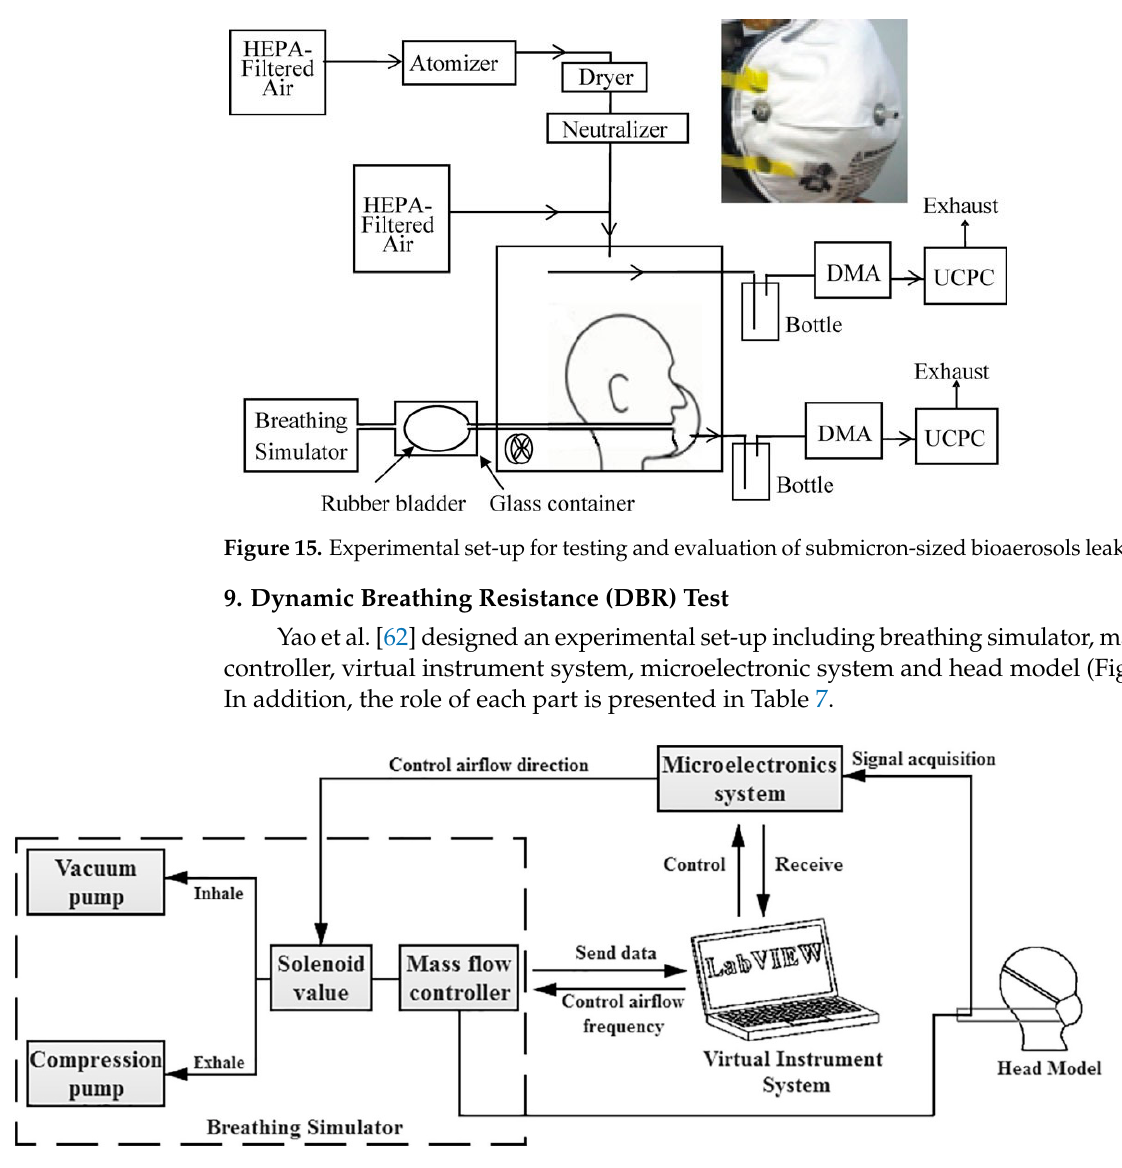
Figure 16. A designed experimental set up for measuring dynamic breathing resistance (DBR) [56]. Table 7. The key elements of DBR machine are illustrated in Figure 16 [63].